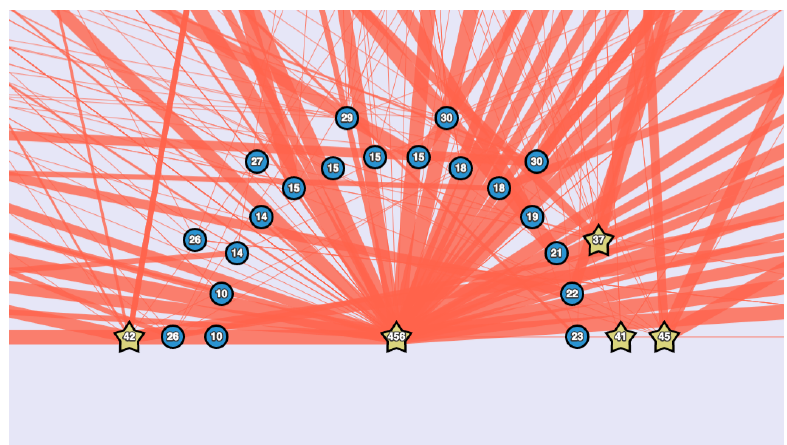
Figure 5. Performance visualization through a concentric layout: ideal scenario.